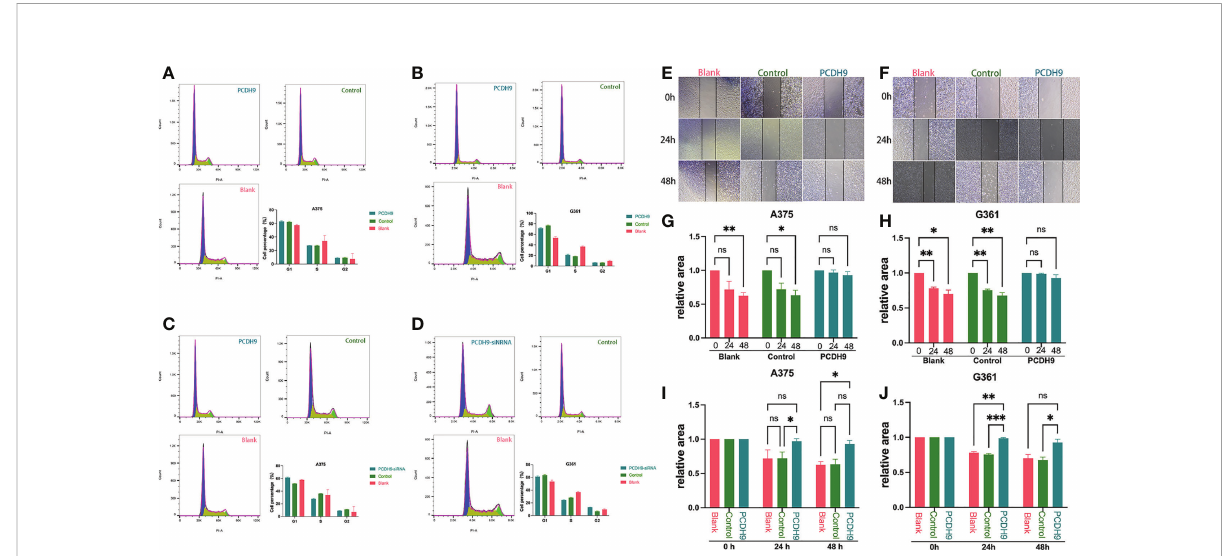
FIGURE 4 The alteration of PCDH9 expression did not affect the melanoma cell cycle. The cell percentage of A375 (A) and G361 (B) cells in G1, S, and G2 phases when PCDH9 was overexpressed. The cell percentage of A375 (C) and G361 (D) cells in G1, S, and G2 phases when PCDH9 interfered. * p < 0.05, ** p < 0.01, and *** p < 0.001 compared groups using one-way ANOVA followed by least signi fi cant difference post-hoc tests. Overexpression of PCDH9 inhibits the migration of melanoma cells. Scratch width of A375 (E) and G361 (F) cells at 0, 24, and 48 h. The scratch area of A375 (G) and G361 (H) cells overexpressing PCDH9 did not alter at 24 and 48 h. After 24 and 48 h, the relative scratch area of the PCDH9 overexpression group was larger than that of the blank group and negative control group in A375 (I) and G361 (J) cells. ns P > 0.05, * p < 0.05, ** p < 0.01, *** p < 0.001 compared groups using one-way ANOVA followed by least signi fi cant difference post hoc